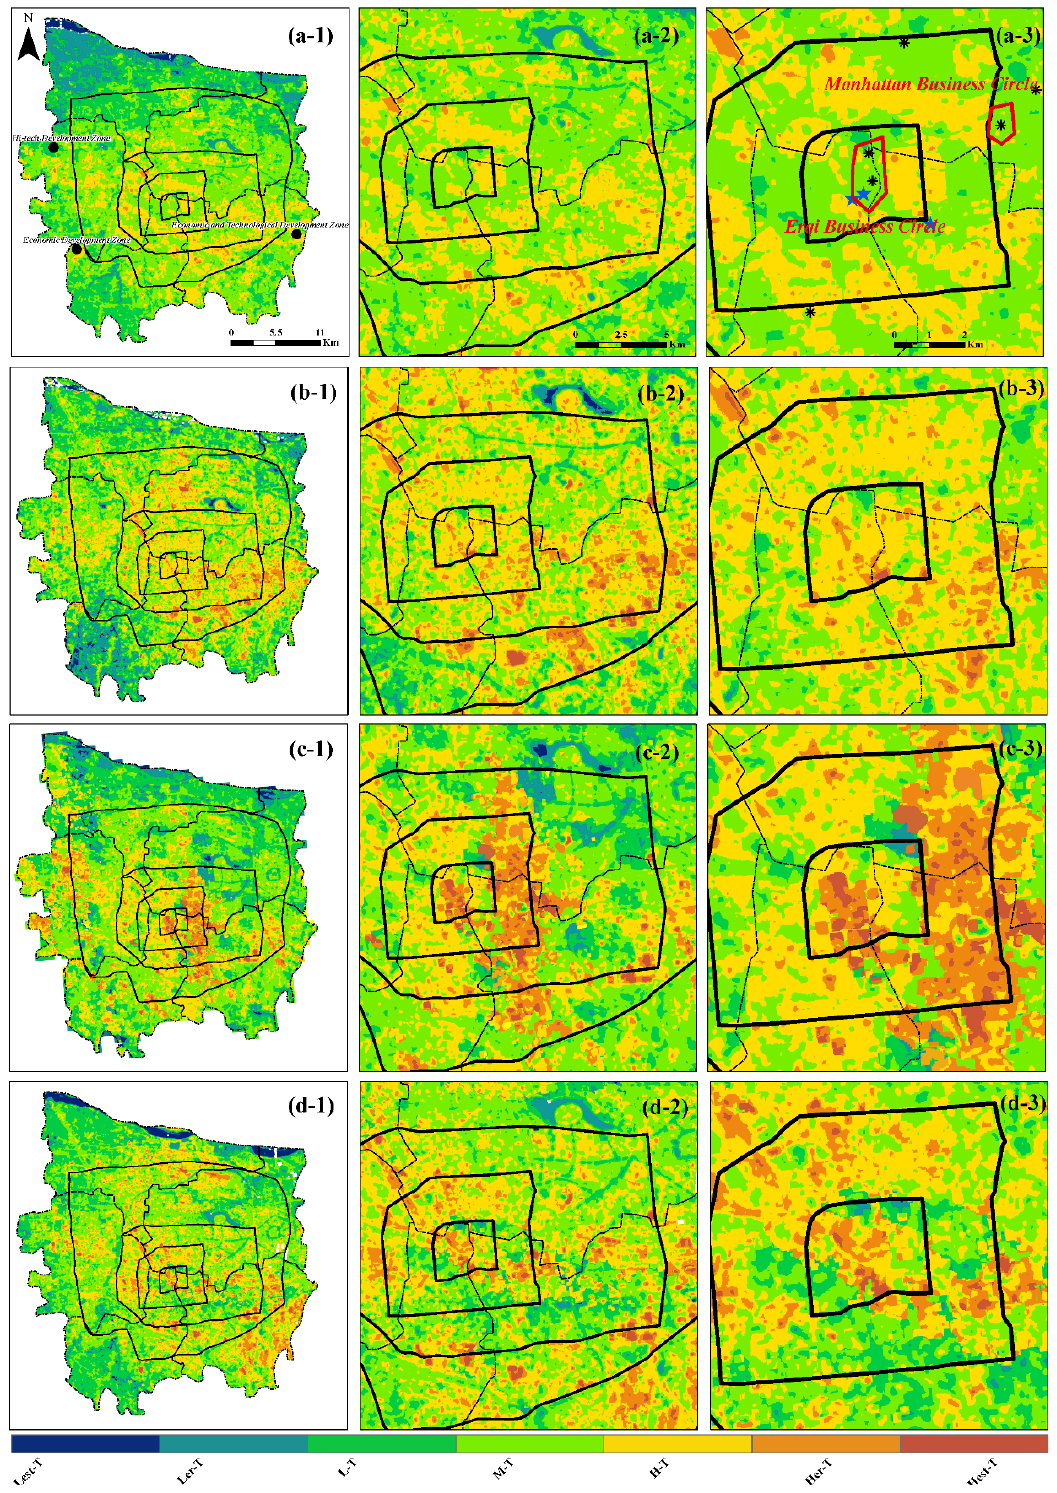
Figure 5. The surface temperature inversions observed in this study in 2013 ( a-1 ), 2015 ( b-1 ), 2018 ( c-1 ) and 2020 ( d-1 ). The surface temperature inversion of the fourth ring line in 2013 ( a-2 ), 2015 ( b-2 ), 2018 ( c-2 ) and 2020 ( d-2 ), and of the first and second ring line in 2013 ( a-3 ), 2015 ( b-3 ), 2018 ( c-3 ) and 2020 ( d-3 ). The points represent major commercial and economic technology development